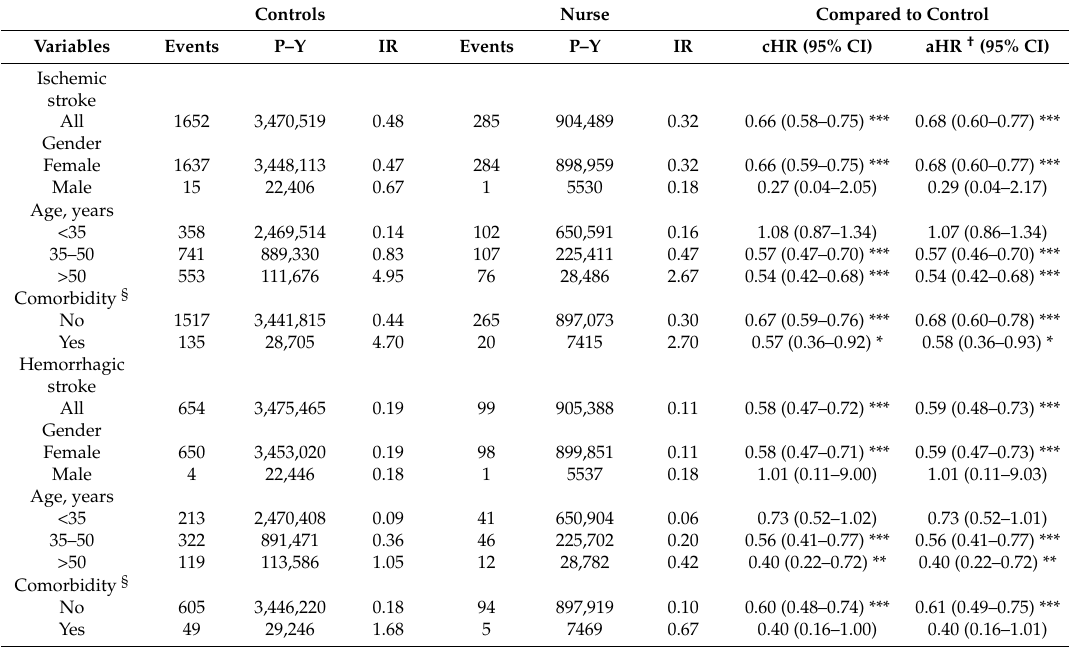
Table 4. Incidence rate and adjusted hazard ratio for ischemic stroke and hemorrhagic stroke for nurse and control groups, stratified by sex, age, and comorbidity. Controls Nurse Compared to